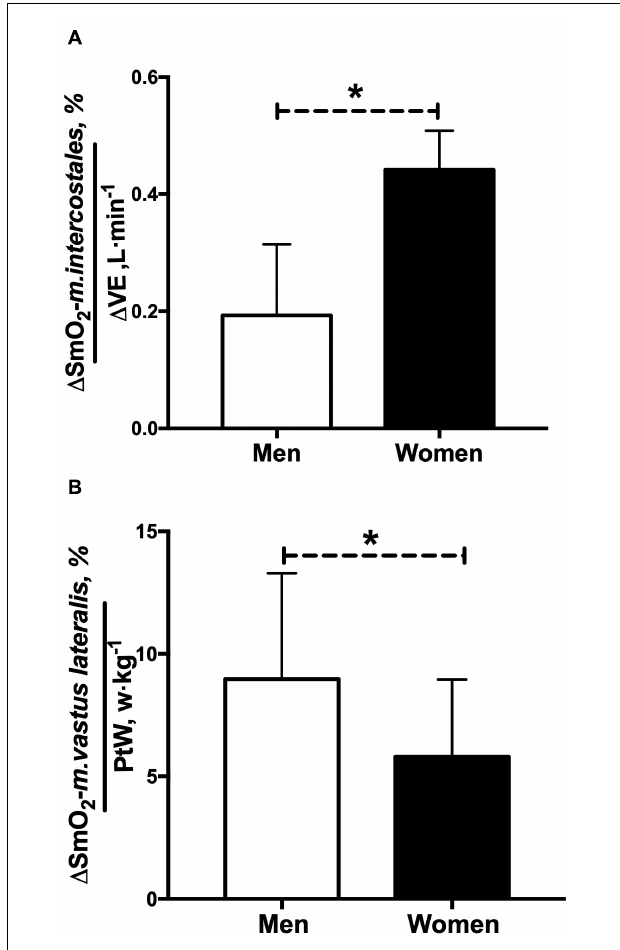
FIGURE 4 | Comparison in SmO 2 between men and women standardized by (A) (cid:49) ˙ VE ( ˙ VE peak— ˙ VE rest phase, (cid:49) SmO 2 - m.intercostales · (cid:49) ˙ VE − 1 ) and (B) PtW (peak workload-to-weight, (cid:49) SmO 2 - m.vastus lateralis · PtW − 1 ). * p <